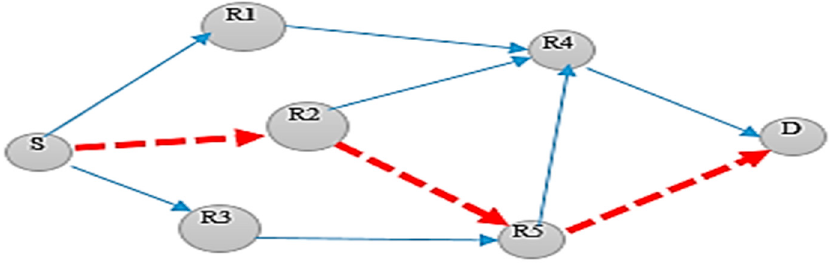
Figure 3. Illustration of the final route selection using IOP.